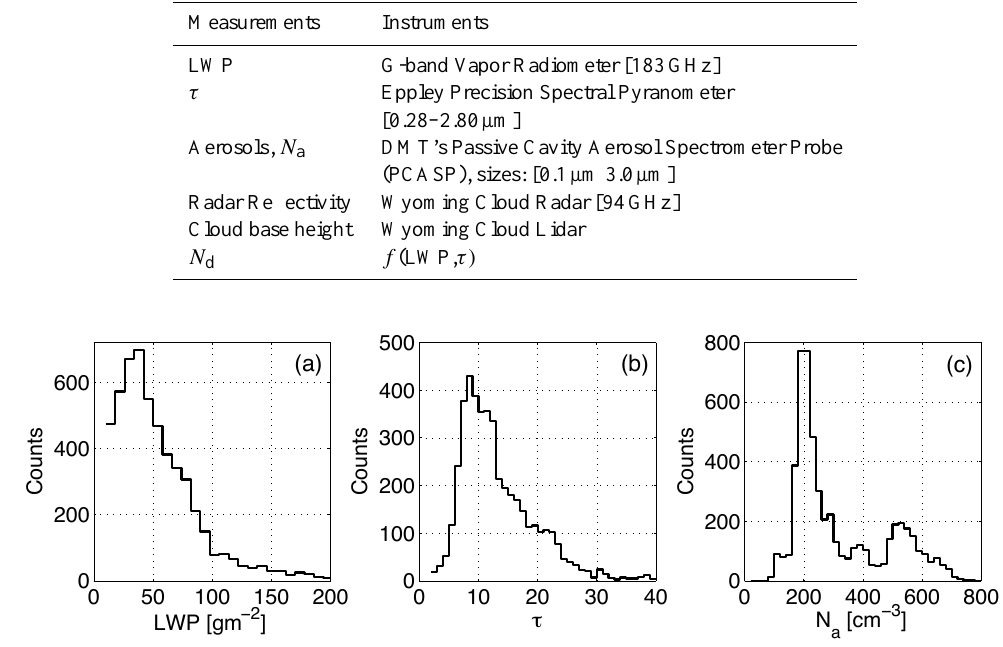
Figure 7: Histograms for the four research flights: a) LWP, b) τ , and c) N Fig. 7. Histograms for the four research flights: (a) LWP, (b) τ , and (c) N a . Histograms were calculated for: LWP > 20 gm − 2 , τ > 2, SZA < 35 ◦ , overcast at 1.4km scale, and column-maximum reflectivity < − 17dBZ. were calculated for: LWP>20 g m -2 , τ >2, SZA<35 0 , overcast at 1.4 km scale, and 998